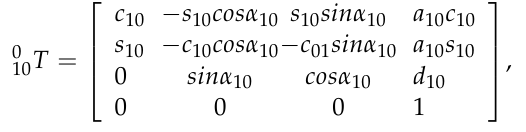
Table 3. D-H parameters for finger base coordinates to palm base